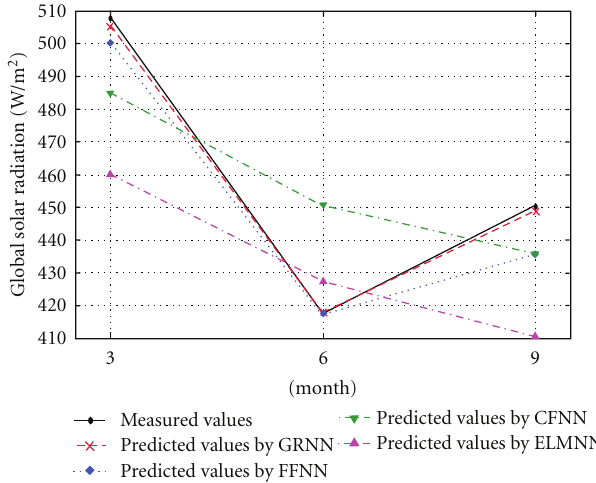
Figure 9: Comparison of measured and predicted values based on monthly averages of global radiation.